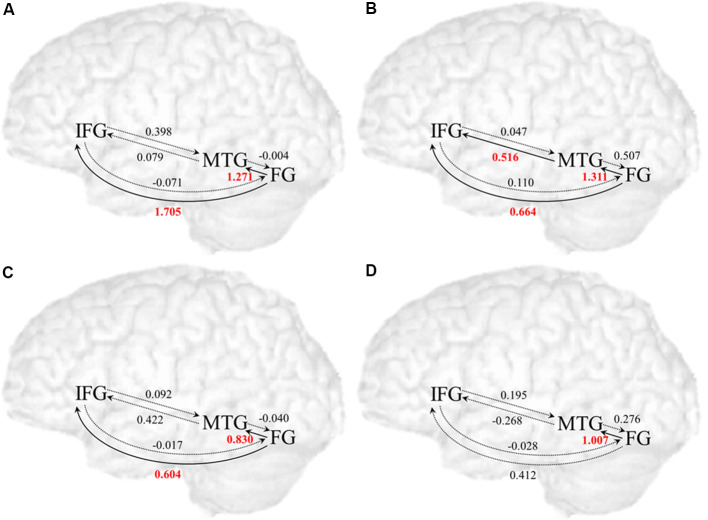
Modulatory effects in the related and unrelated conditions among all regions for the adult and child group. (A) Modulatory effects in the related condition for the adult group. (B) Modulatory effects in the unrelated condition for the adult group. (C) Modulatory effects in the related condition for the child group. (D) Modulatory effects in the unrelated condition for the child group. Solid line arrows indicate significant influences on modulated connections (p < 0.008 with p < 0.05 corrected for six comparisons), and dotted line arrows indicate non-significant connections.